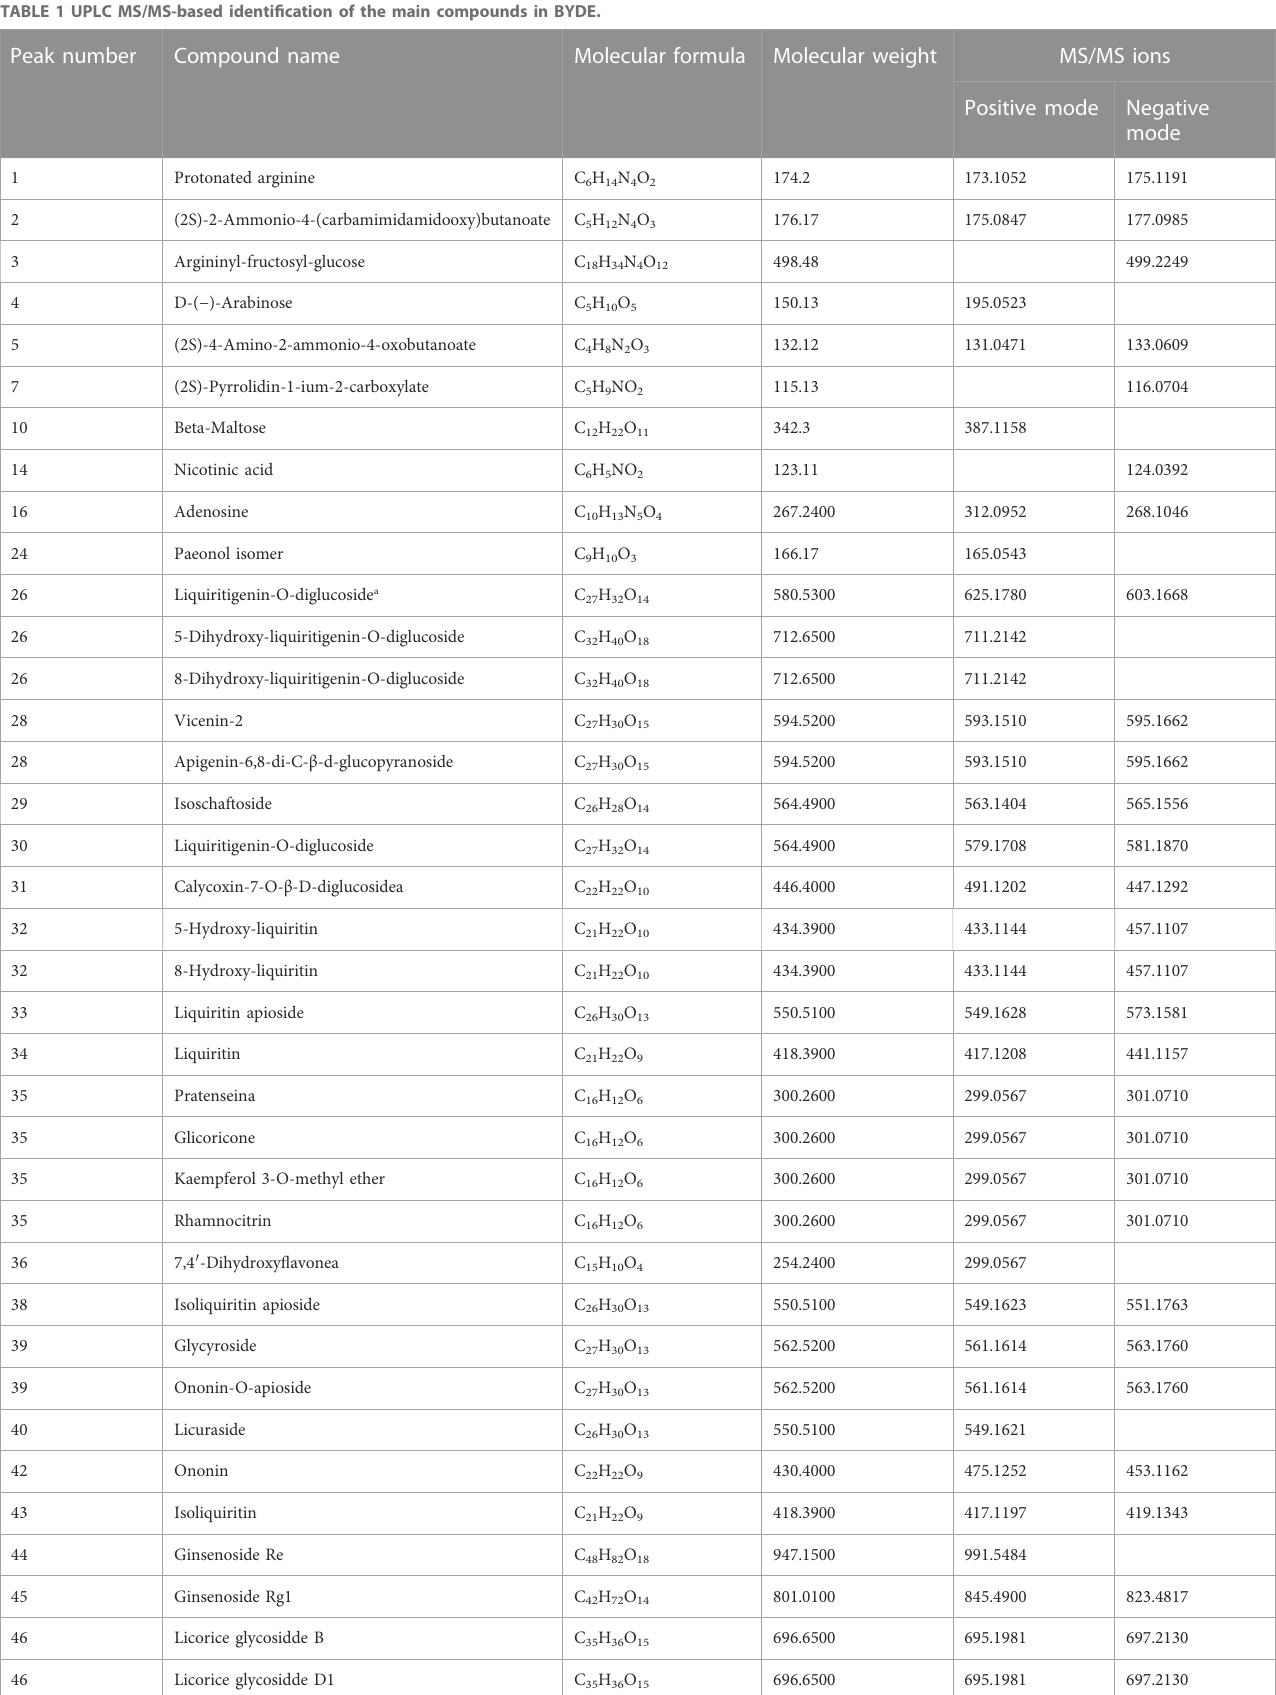
TABLE 1 UPLC MS/MS-based identi fi cation of the main compounds in